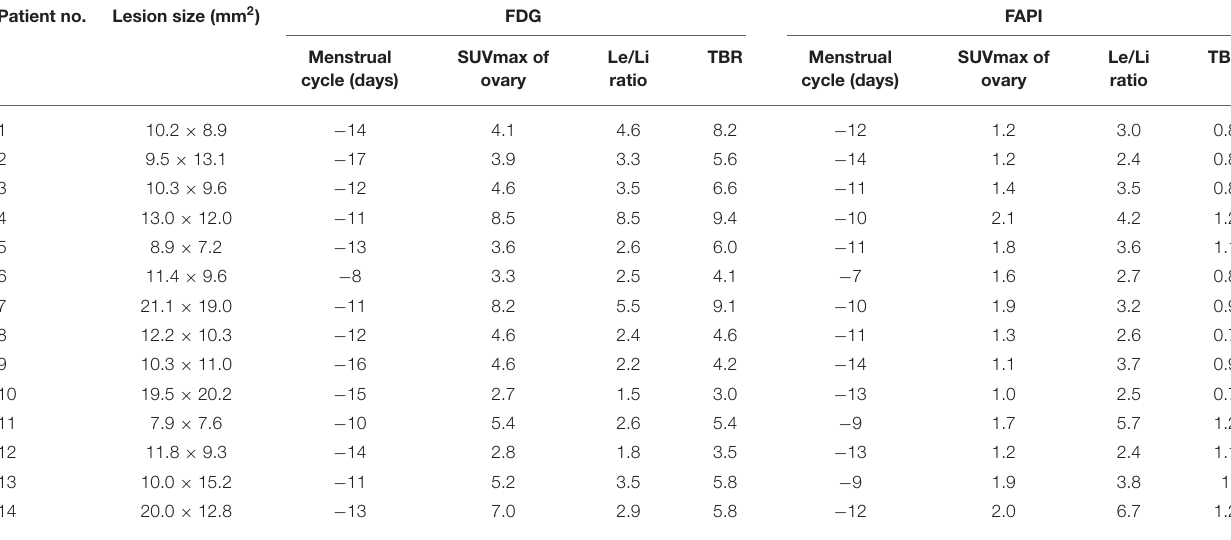
TABLE 2 | Summary of 18 F-FDG and 68 Ga-DOTA-FAPI-04 PET/CT images. Patient